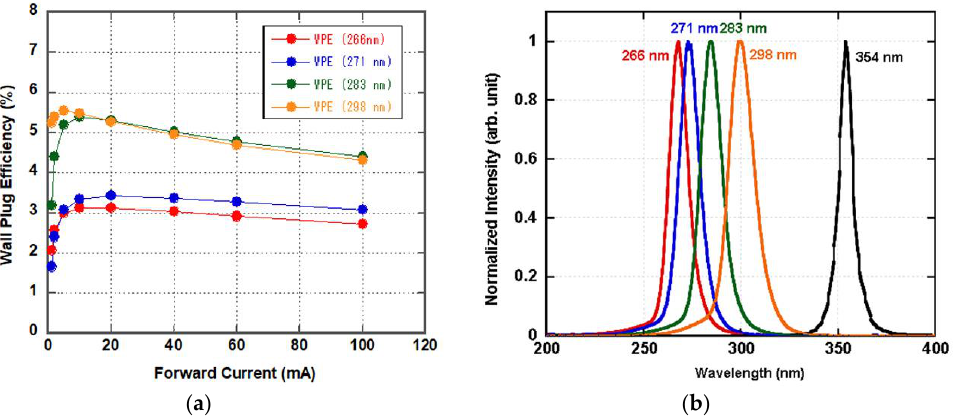
Figure 13. ( a ) WPEs of AlGaN-based DUV-LED bare dies; and ( b ) their EL spectra, with an LED with a GaN well (354 nm) having a spectral width of 75 meV shown for a reference without ternary disordering. The samples are the same as those in Figure 12 and the EL spectral widths are greater than 200 meV for the AlGaN wells, also suggesting potential fluctuation at the QWs. (( a ) is calculated WPE from Figure 12. ( b ) is permitted to be reused from [13]. © Japan Society Applied Physics). Table 2. IQEs estimated from the fixed LEE and CIE. To show the expected range of the IQE at 40 mA, the values in the lower rows are considered to be the more probable IQEs. The values with CIE/LEE of 100/10 are conservative estimates for 283 and 298 nm LEDs. The values with CIE/LEE of 80/10 are the possible conservative estimates for the 266 nm LEDs, assuming that the CIE at 265 nm is 20% less than those of 283–298 nm LEDs. (Calculated from the data at 40 mA in Figure 12.).